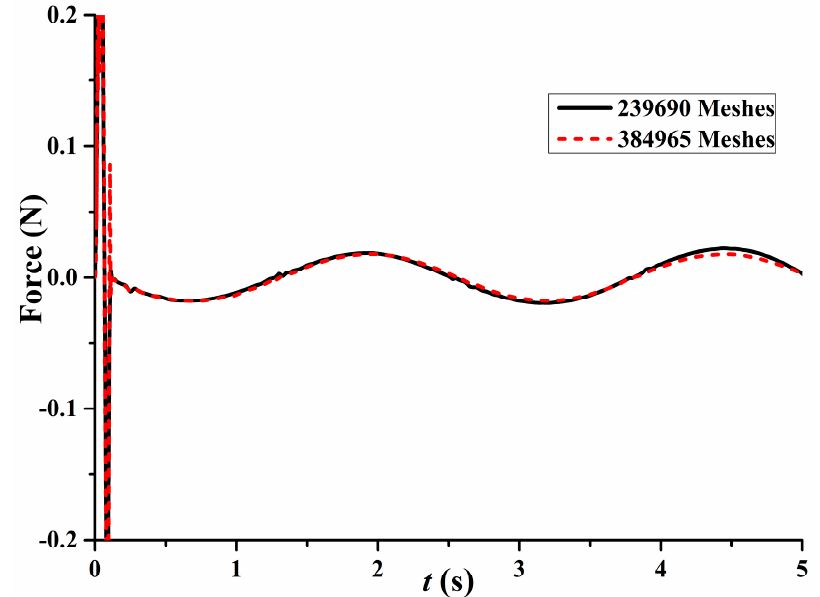
Figure 12. The force acting on the four ellipsoid floats in the water as a function of t at two different mesh numbers.